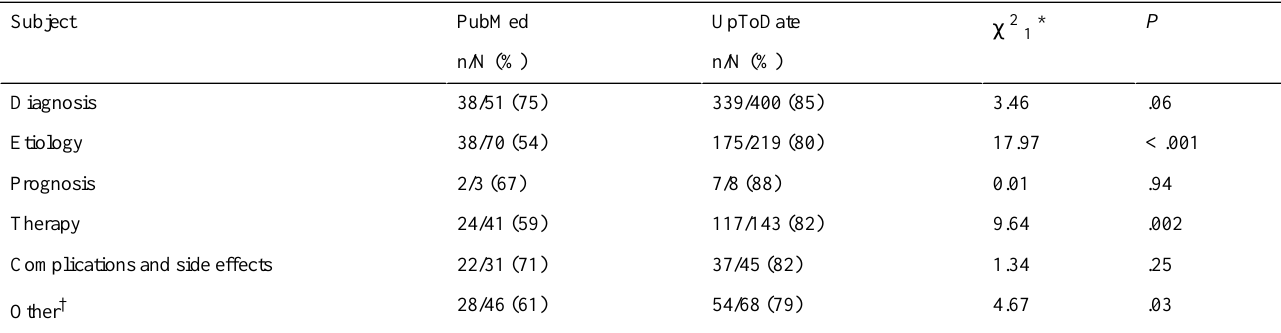
Table 3. Number and percentage of partial or full answers found to questions sent to only one of the two databases, by subject (N = 1125)